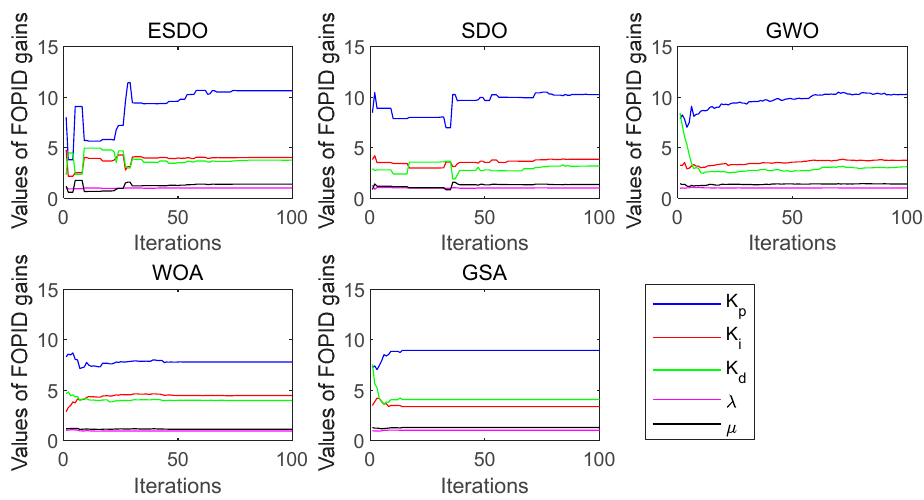
Figure 16. Convergence curves of FOPID parameters with 12% load.